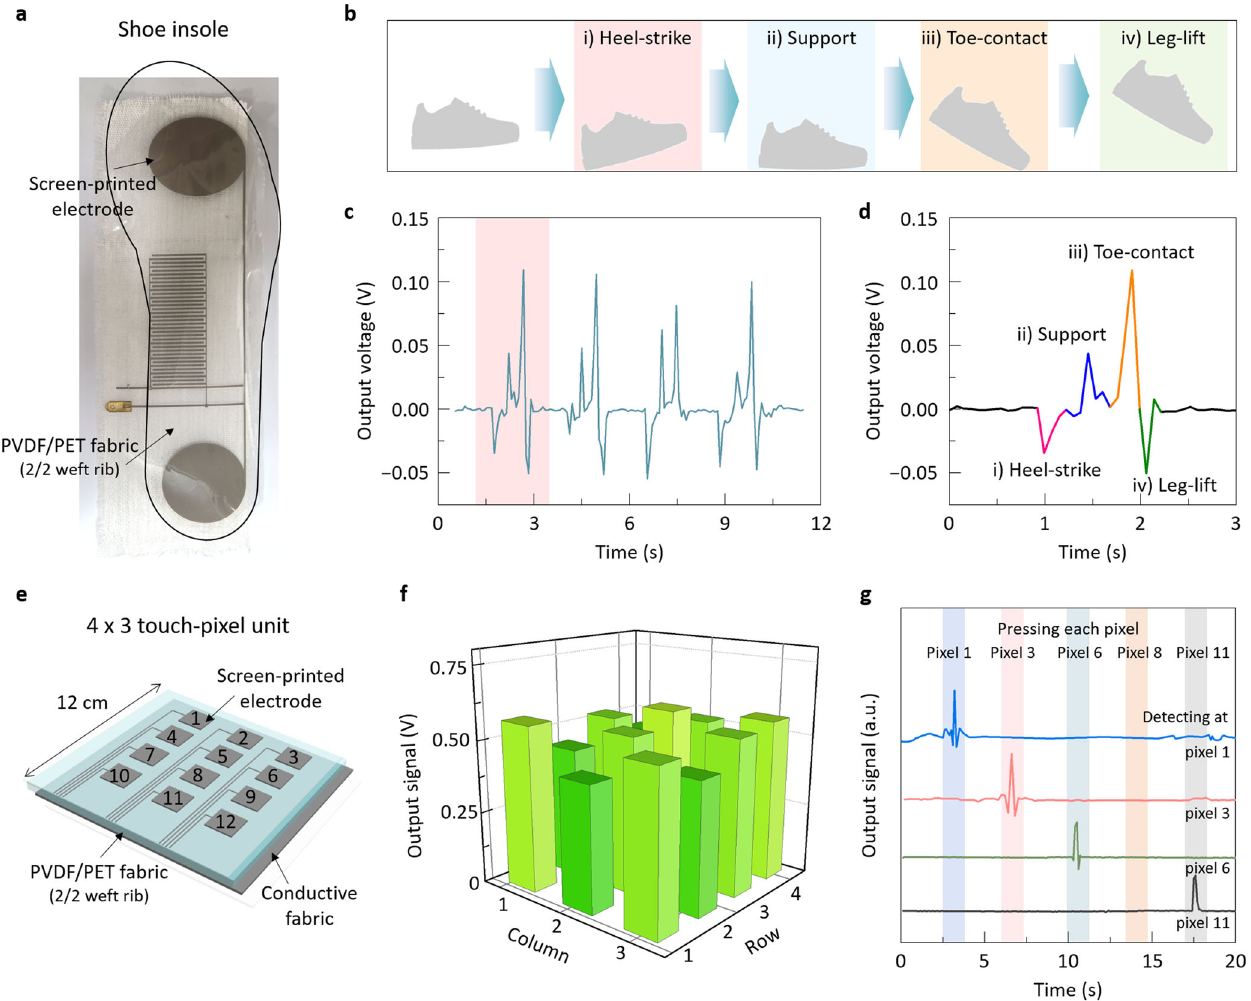
Fig. 6 Extended applications of all-fabric pressure sensors. a Example of a shoe-insole pressure sensor fabricated from the 2/2 weft rib fabric, which was inserted below two circular electrodes to detect the front (just below the toes) and heel motions. b Schematic illustrations of each stage of a single step during walking: heel-strike, support, toe-contact, and leg-lift. c Output voltage signals in response to each part of a walking step for gait analysis, and d the magni fi ed electrical signals correlated with each stage in a step. e Schematic of all-fabric pressure sensors with an array of box-type pixel units numbered up to 12, with the conductor lines patterned for detecting separate signal from each pixel. f Three-dimensional plots of electrical signals produced by fi nger-pressing of each pixel. g Electrical signals detected only at the pixel pressed by fi nger, without the creation of side-signals at other pixels, con fi rming no